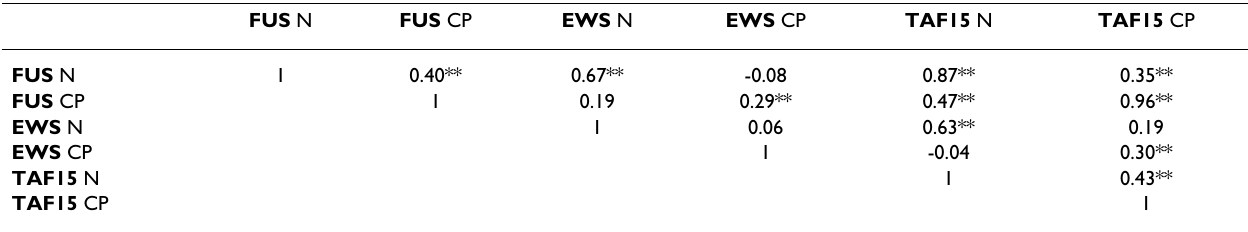
Table 2: Calculated Spearman correlations of FET expression patterns from Table